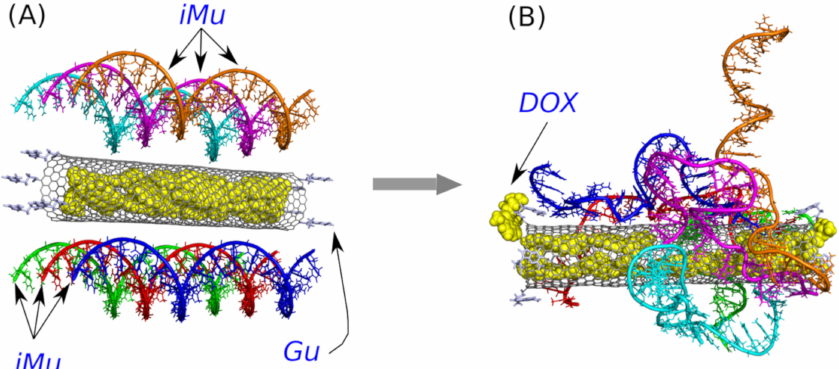
Figure 2. ( A ) The initial structure with doxorubicin (DOX) encapsulated in the CNT interior and six unprotonated iM sequences, iMu, placed in the vicinity of the CNT surface. For a better clarity, each iMu is drawn in di ff erent color though all of them are identical. Carbon nanotube is on-tip functionalized by guanine, Gu, residues. ( B ) The same structure after 40 ns of